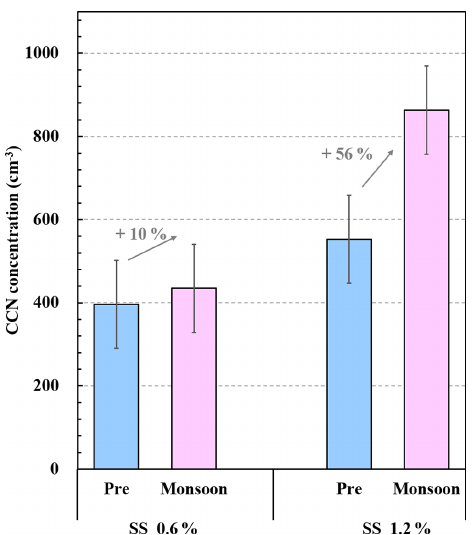
Figure 8. Mean number concentration of CCN at S c of 0.6% and 1.2% in the pre-monsoon and monsoon